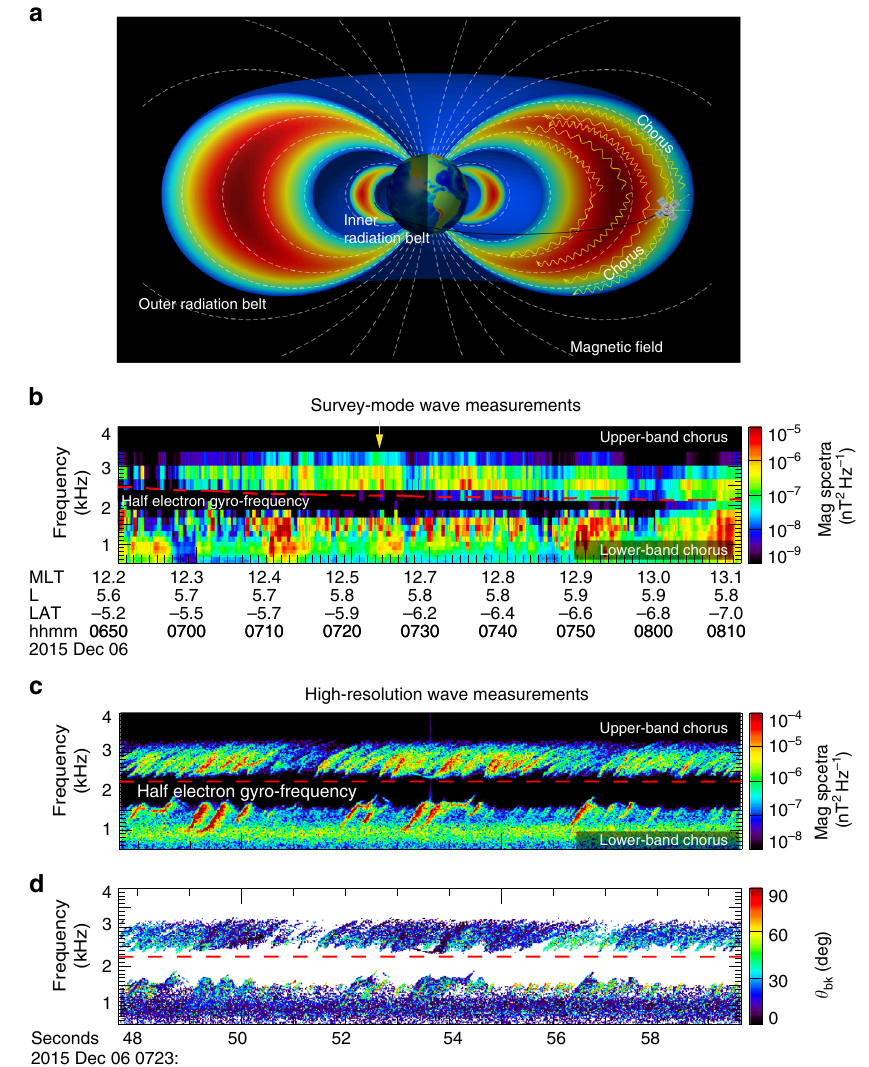
Fig. 1 Van Allen Probe-A orbit and observations of two-band chorus waves. a The con fi guration of outer and inner radiation belts that are con fi ned by Earth ’ s magnetic fi eld (the colors are not from any speci fi c data), as well as the Van Allen Probe orbit and its position at 07:23 UT on 6 December 2015. b 80-min overview of survey-mode magnetic wave spectral intensity, showing two-band chorus waves separated by a gap around half electron gyro- frequency, which is represented by a dashed red line. c 12-second high-resolution measurements of magnetic wave spectral intensity during the time indicated by a yellow arrow in Fig. 1b, showing discrete rising-tone elements in each band. d The wave normal angles calculated from the waveform data using the Means method 41 , showing that the chorus waves propagate mostly at wave normal angles of 0º – 30º with respect to the magnetic fi